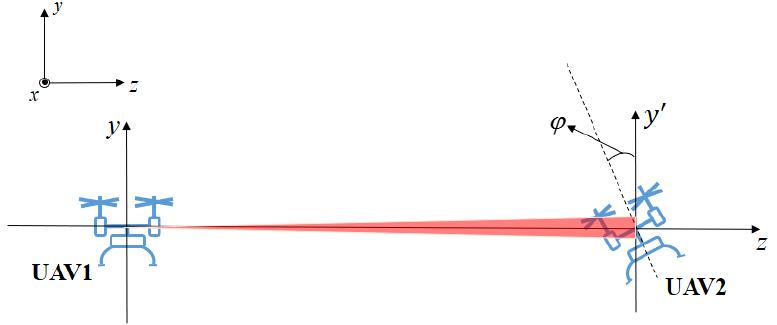
Figure 1. Diagram of the in-flight unmanned aerial vehicle (UAV) free-space optical (FSO) com-